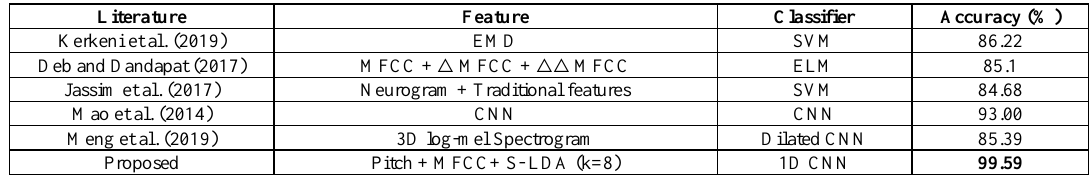
Table 6 . Performance comparison of present work with the state of the art methods for EMO-DB database.